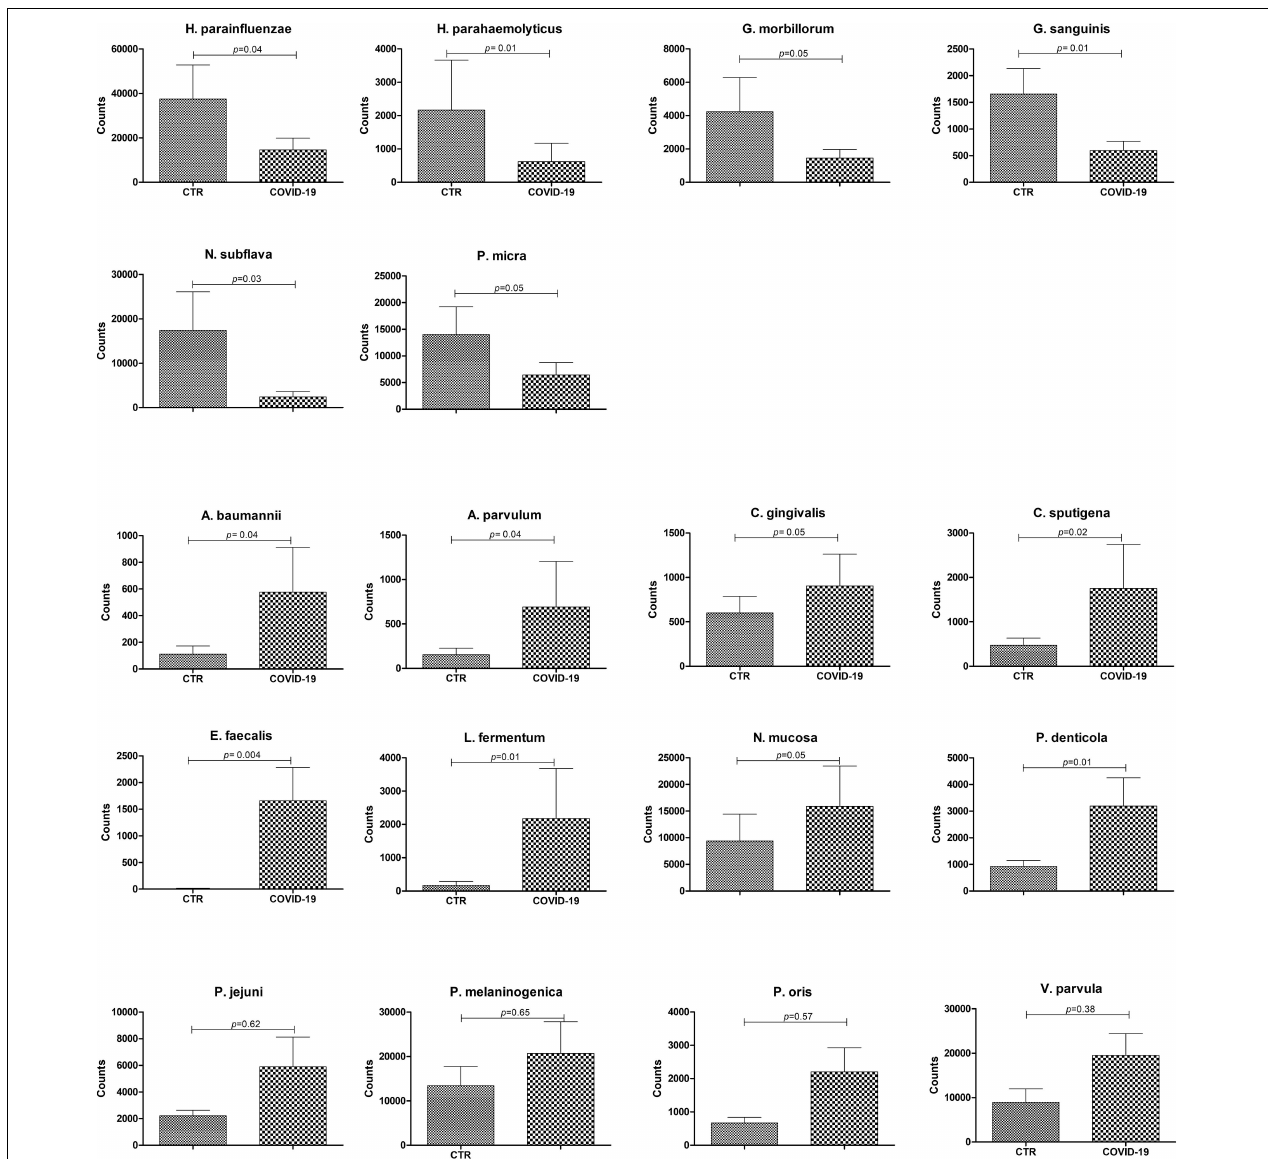
FIGURE 4 | Significantly altered taxa in control (CTR) and COVID-19 subjects. The results are expressed as normalized counts ± SEM values. Significance p -values for each comparison are also